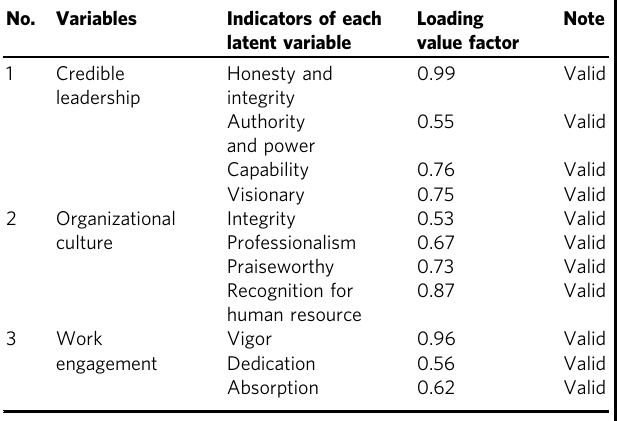
Table 3 Construct validity test results.